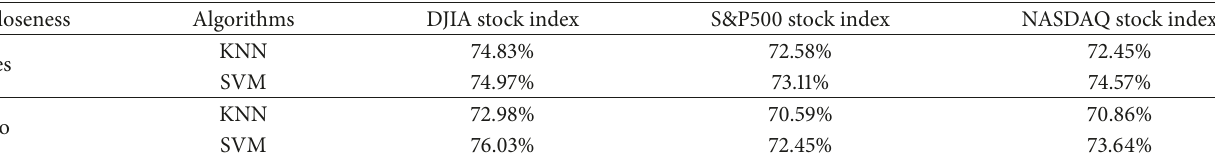
Table 3: Prediction accuracy of the optimal KNN and SVM models in relation to next-day patterns for the three stock indexes using the testing